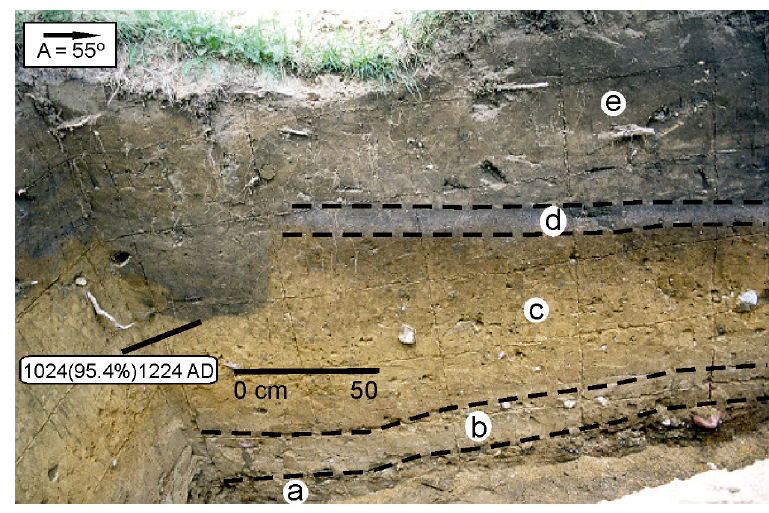
Fig. 5. Geological structure of the bottom of the J3 valley: a, gravel–sand–boulder level; b, sand with an admixture of gravels; c, medium-grained and coarse sands; d, fossil podzolic soil; e, sand and silt